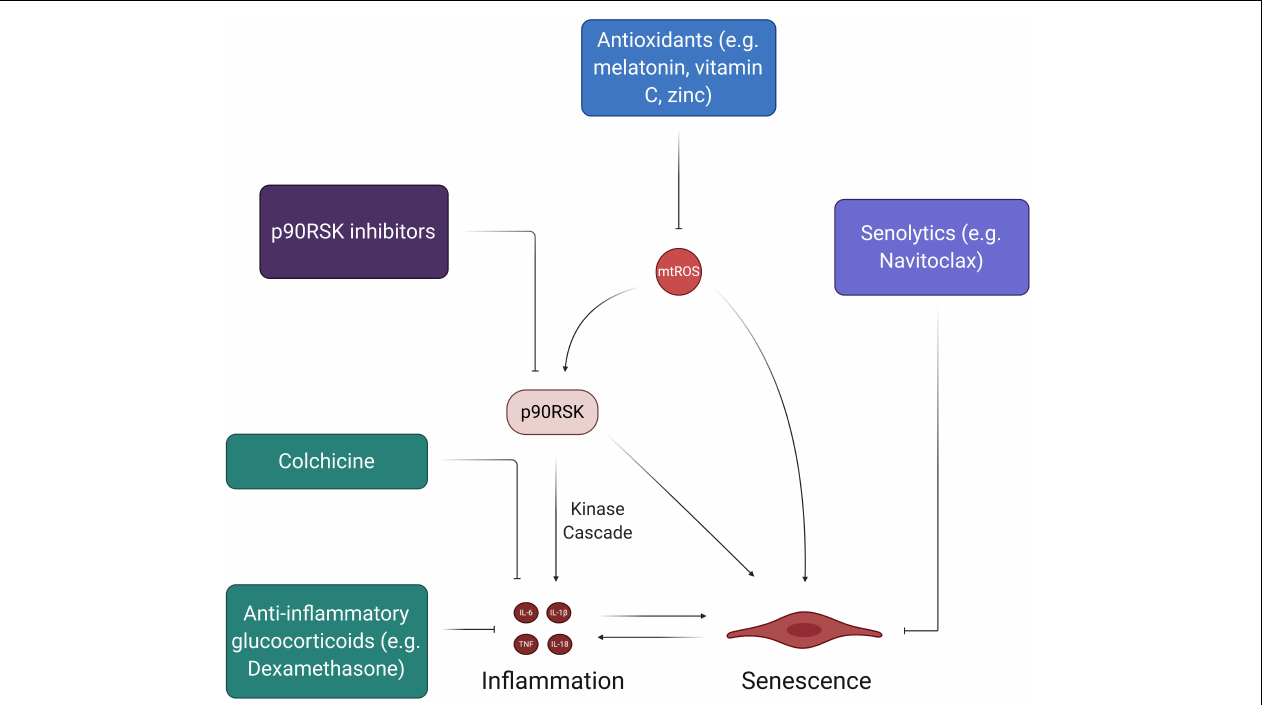
FIGURE 8 | Therapies to address SARS-CoV-2-induced feedback loops in ECs. While there have been many therapies proposed to halt the spread of the coronavirus pandemic, the ones depicted here address the feedback loops involving oxidative stress and inflammation. The chronic, self-feeding nature of mtROS, inflammation, and senescence provide various targets for treatment. For example, antioxidants can prevent the accumulation of excess mtROS, thus reducing the inflammatory effects of mtROS-induced cytokine production and SASP. Likewise, senolytics, which induce apoptosis of senescent cells, can reduce the pro-inflammatory state associated with SASP and prevent further induction of senescence in the